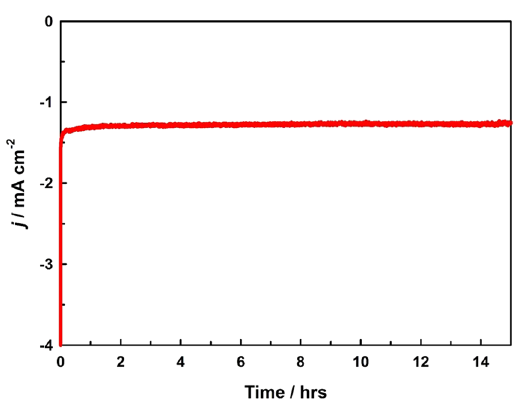
Figure 6. The stability test of the optimized nanocomposite electrode carried at − 0.5 V in a CO 2 -saturated 0.1 M NaHCO 3 solution under continuous CO 2